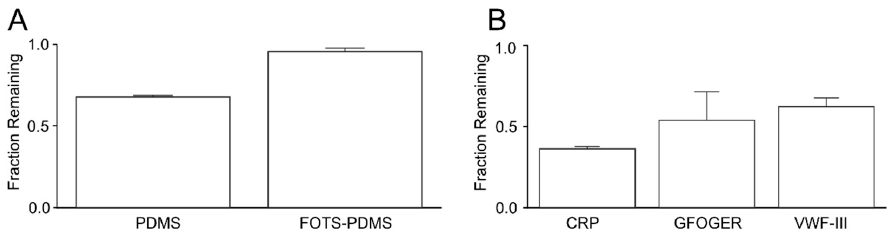
Figure 6. Depletion of collage peptides incubated in PDMS devices. Collagen related peptides were incubated at 250 µ g / mL either together (total peptide concentration = 750 µ g / mL) or separately (peptide concentration = 250 µ g / mL) in a PDMS microfluidic device, and their concentration was measured after 2h. ( A ) Fraction of remaining peptides after incubation on PDMS or FOTS-PDMS. ( B ) Fraction of remaining individual after incubation in PDMS. Error bars show standard deviation of n = 3 measurements.